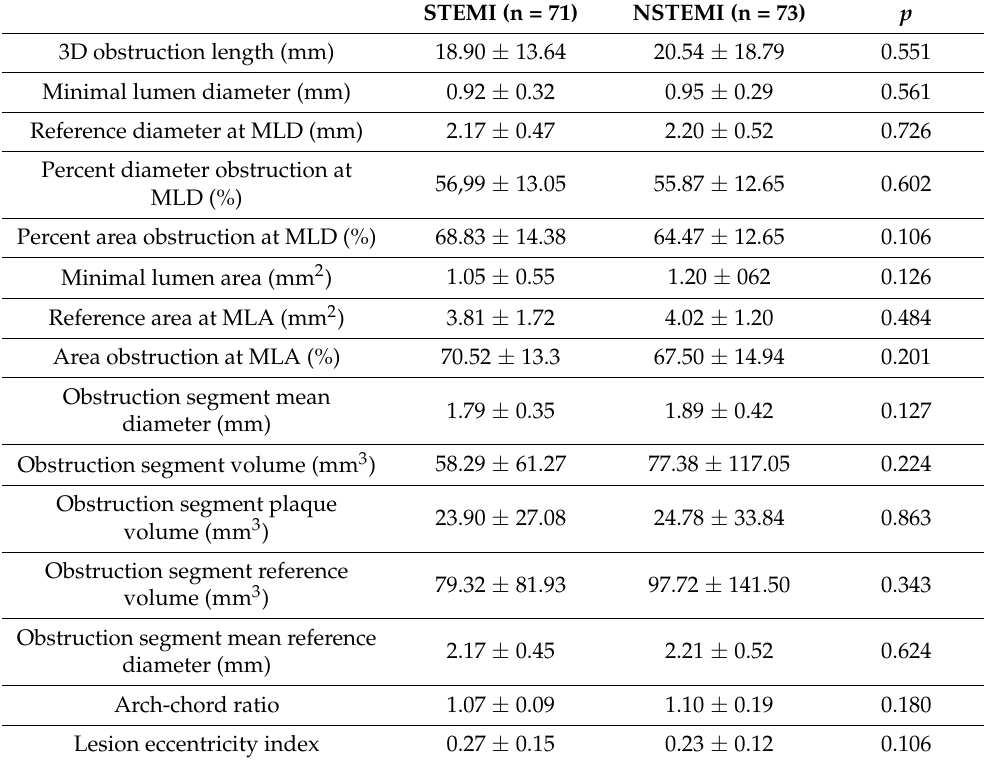
Table 3. 2/3D parameters; no significant differences